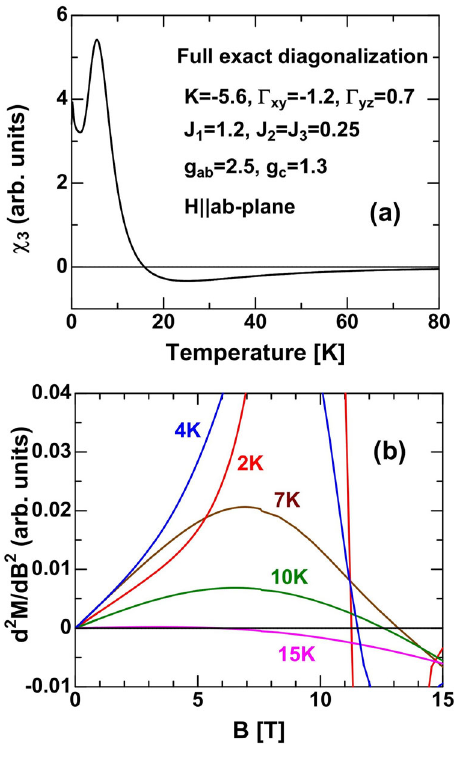
Fig. 5 Exact diagonalization calculations. This fi gure shows the nonlinear susceptibility χ 3 in calculations employing exact diagona- lization for B in the ab -plane. The results obtained are identical whether B ∥ a -axis or B ⊥ a -axis. χ 3 (panel (a)) rises rapidly to positive values at T N reaches a maximum and saturates to a large positive value at T = 0. However, the zero-crossing occurs within 2 T N , whereas the experimental zero-crossing occurs at a much higher temperature. Panel (b) shows the second derivative, d 2 M /d B 2 , at various temperatures. This derivative passes zero at all tempera- tures — thus implying the absence of a B 2 term in the magnetization contrary to experimental fi